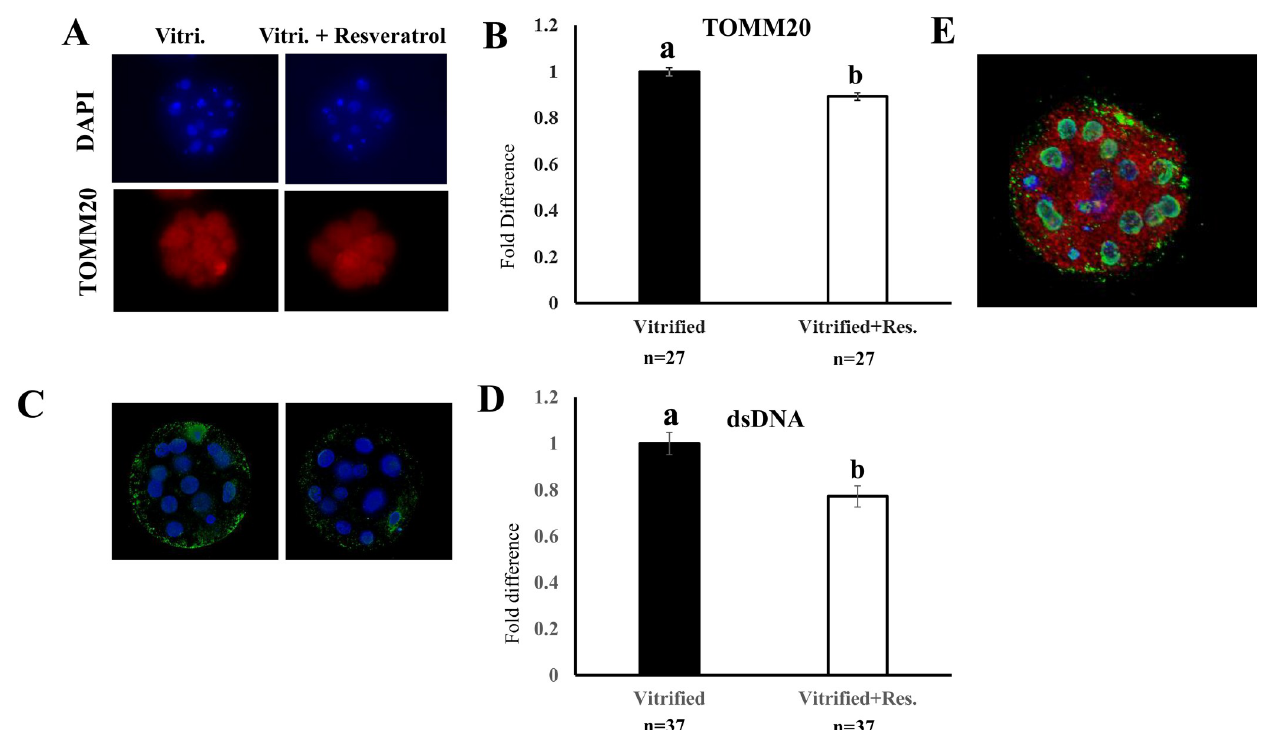
Fig 7. Effect of resveratrol supplementation of the culture medium on TOMM20 and double-stranded DNA (dsDNA) levels in vitrified-warmed embryos. Vitrified-warmed embryos were cultured with or without (0 or 0.5 μ M) resveratrol for 24 h, and the embryos were stained for TOMM20 (an outer mitochondrial membrane protein) and dsDNA. A) and C): Representative images of embryos stained with antibodies against TOMM20 and dsDNA, respectively, B) and D): Levels of TOMM20 (n = 27) and dsDNA (n = 37), respectively. Levels of TOMM20 and dsDNA in vitrified-warmed embryos cultured without resveratrol (vehicle) were defined as 1.0. E) A representative image of embryos stained for TOMM20 (red), dsDNA (green), and nucleus (blue); ten stacked images of 0.03 μ m thickness captured in the equatorial region of the embryo. Bars with different letters represent differences between treatments (P < 0.05). Data are presented as mean ±